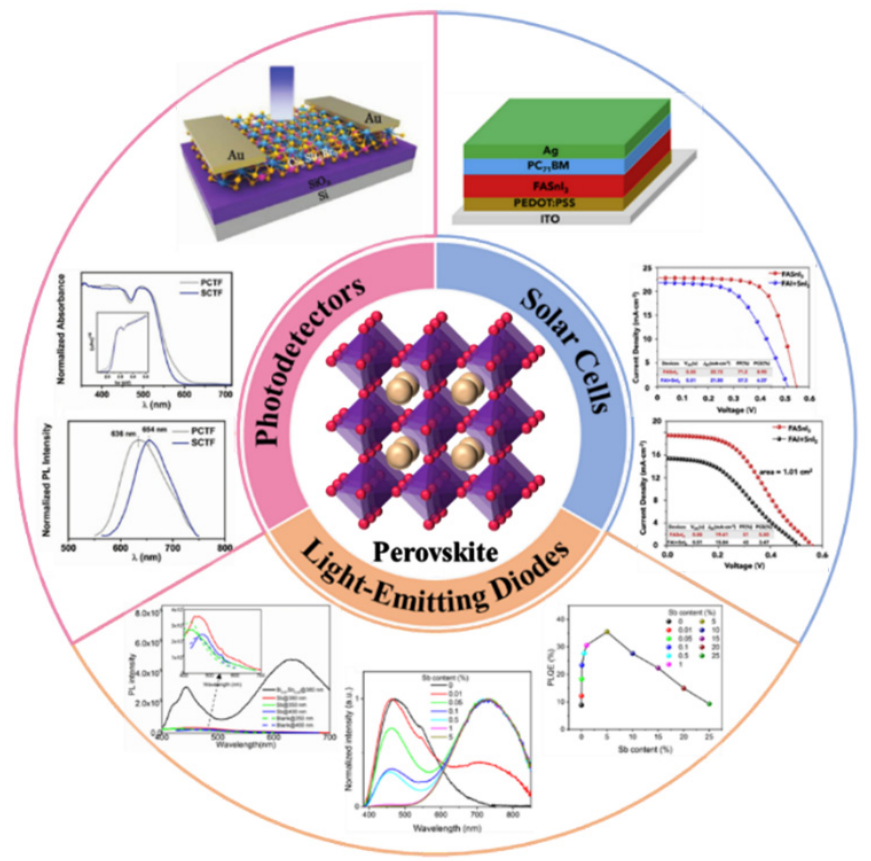
Figure 2. Illustration of various remarkable properties of LFPSCs in practical applications, includ- ing photodetectors, X-ray detectors, and light-emitting diodes. Reprinted (adapted) with permis- sion from Reference 23. Copyright 2021 WILEY-VCH Verlag GmbH & Co. KGaA,